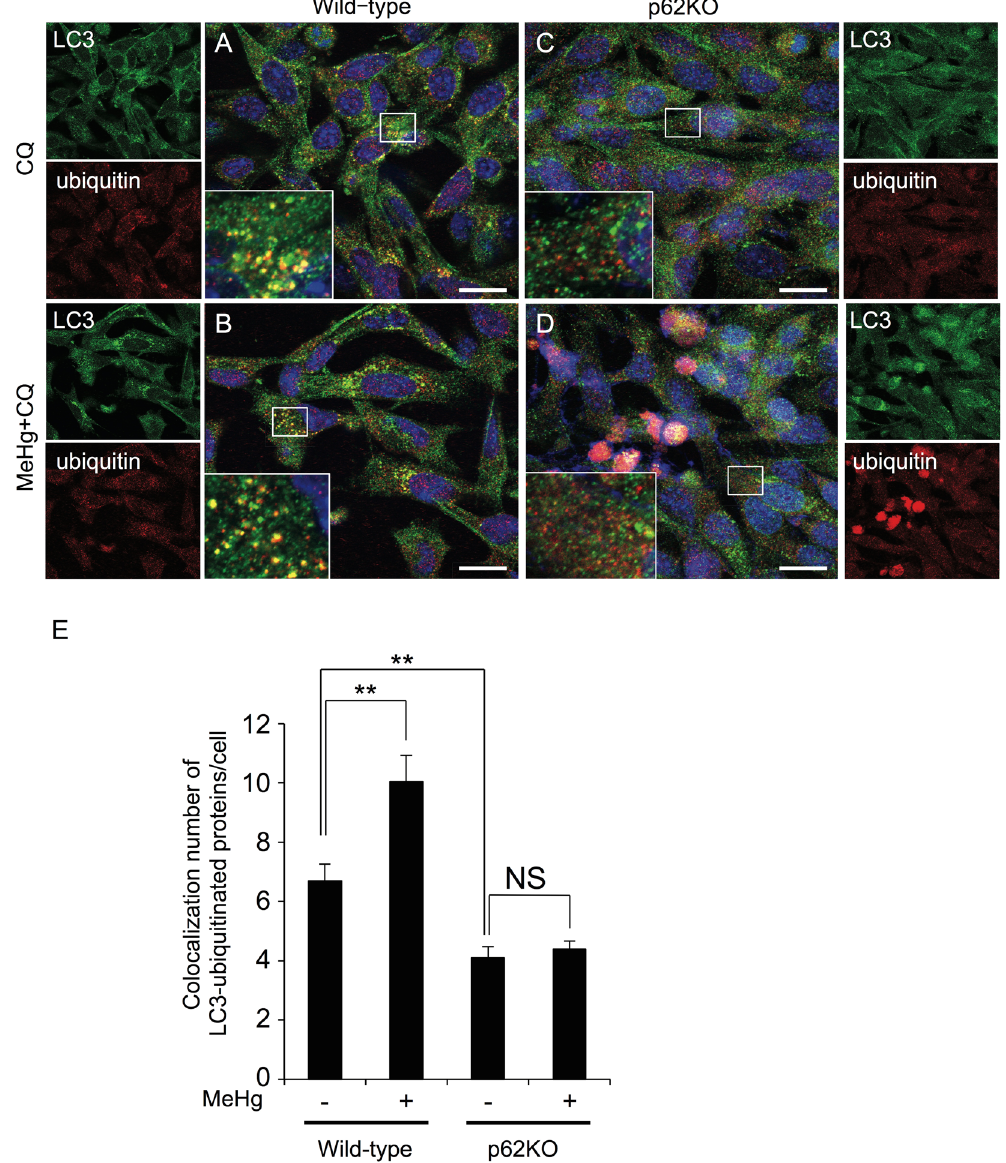
Figure 6. Co-localization of LC3 with ubiquitinated proteins is impaired in the absence of p62. Wild-type and p62 knockout (KO) mouse embryonic fibroblasts (MEFs) were immunostained for endogenous LC3 (green) and ubiquitinated proteins (red), and imaged using confocal microscopy. WT and p62KO MEFs were treated with 20 µ M chloroquine (CQ) for 6 h ( A , C ) or with 1 µ M MeHg for 18 h before incubation with 20 µ M CQ for 6 h ( B , D ). The boxed areas in the composite images are shown at a higher magnification. Scale bars: 20 µ m. ( E ) Quantification of the number of colocalizations was performed in 20 cells. Results are shown as mean ±